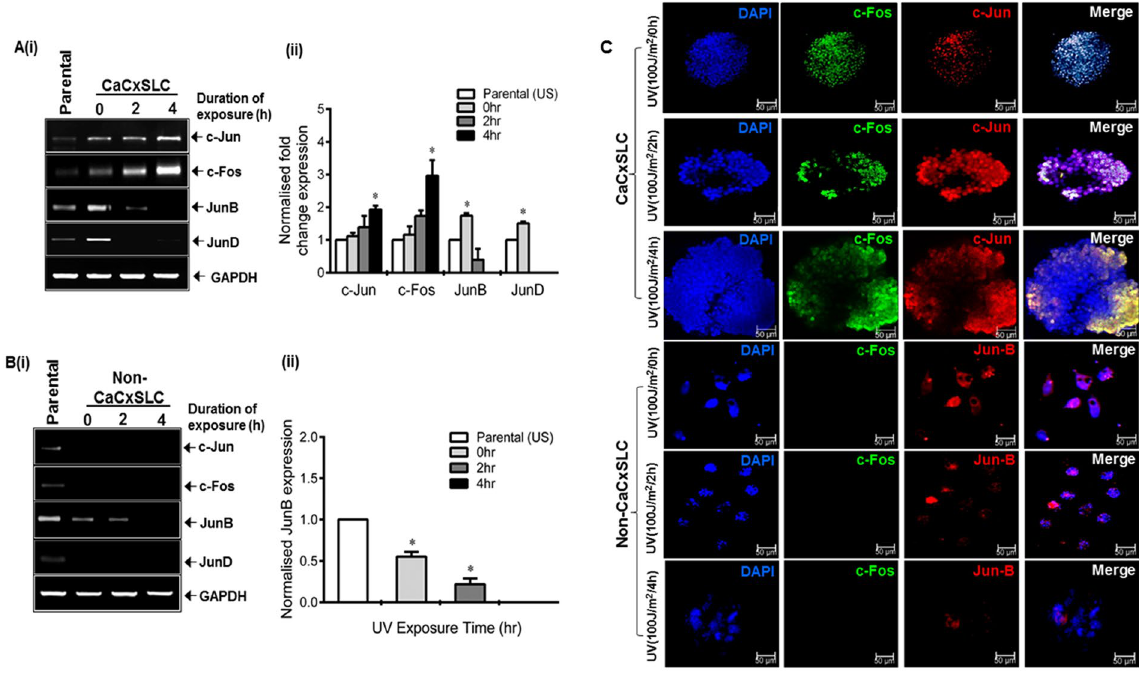
Figure 4. Effect of UV on cervicosphere and expression and localization of AP-1 proteins. ( A , B ) Effect of UV irradiation on transcript levels of respective AP-1 family members. Representative cropped gel photograph showing specific transcript levels of c-Jun, Jun-D, c-Fos and Fra-1 in cDNA prepared from untreated CaCxSLCs and corresponding non-CaCxSLC cells by qRT-PCR ( A (i), B (i)). Parental SiHa (unsorted) cells were used as reference. GAPDH qRT-PCR was used as input control for normalization as described in Methods. The gels were run under the same experimental conditions. Normalized fold change in transcript levels is expressed as mean ± SD of three independent experiments ( A (ii), B (ii)). * p-value < 0.05 vs. parental SiHa cells. ( C ) Representative confocal immunofluorescence image of 10 day CaCxSLCs or non-CaCxSLCs cultures treated with indicated exposure to UVC radiation. Each culture were fixed and stained with primary (c-Fos, c-Jun or Jun-B) and secondary antibodies [Alexa-488 (Green) conjugated goat anti-mouse or Alexa-594 (Red) conjugated goat anti-rabbit] and counterstained with DAPI (Blue) to visualize nuclei. White spots in merged photograph indicate co-localization of AP-1 in